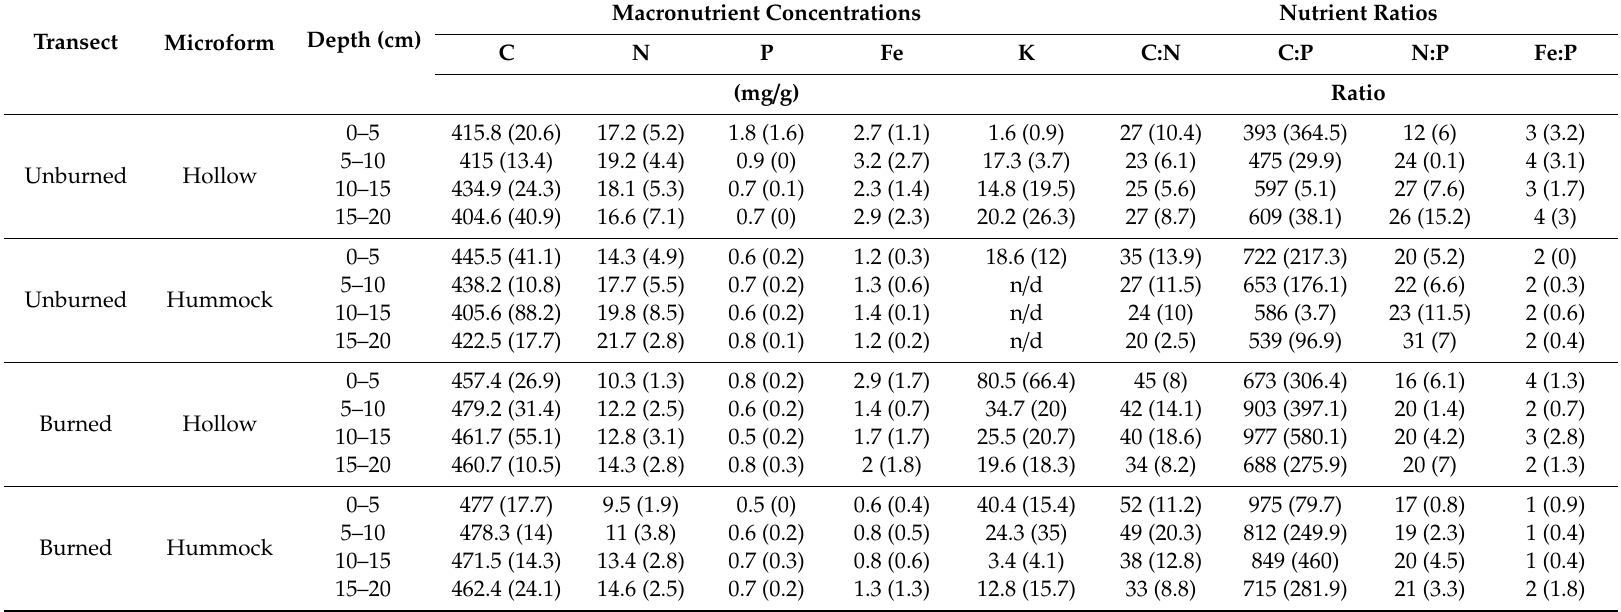
Table 1. Carbon and macronutrient concentrations and nutrient ratios are shown from peak season period, comparing the Unburned and Burned areas and the microtopographical di ff erences. Standard deviations of samples are provided in parentheses. n / d is the result of samples being below the detection limit of the ICP